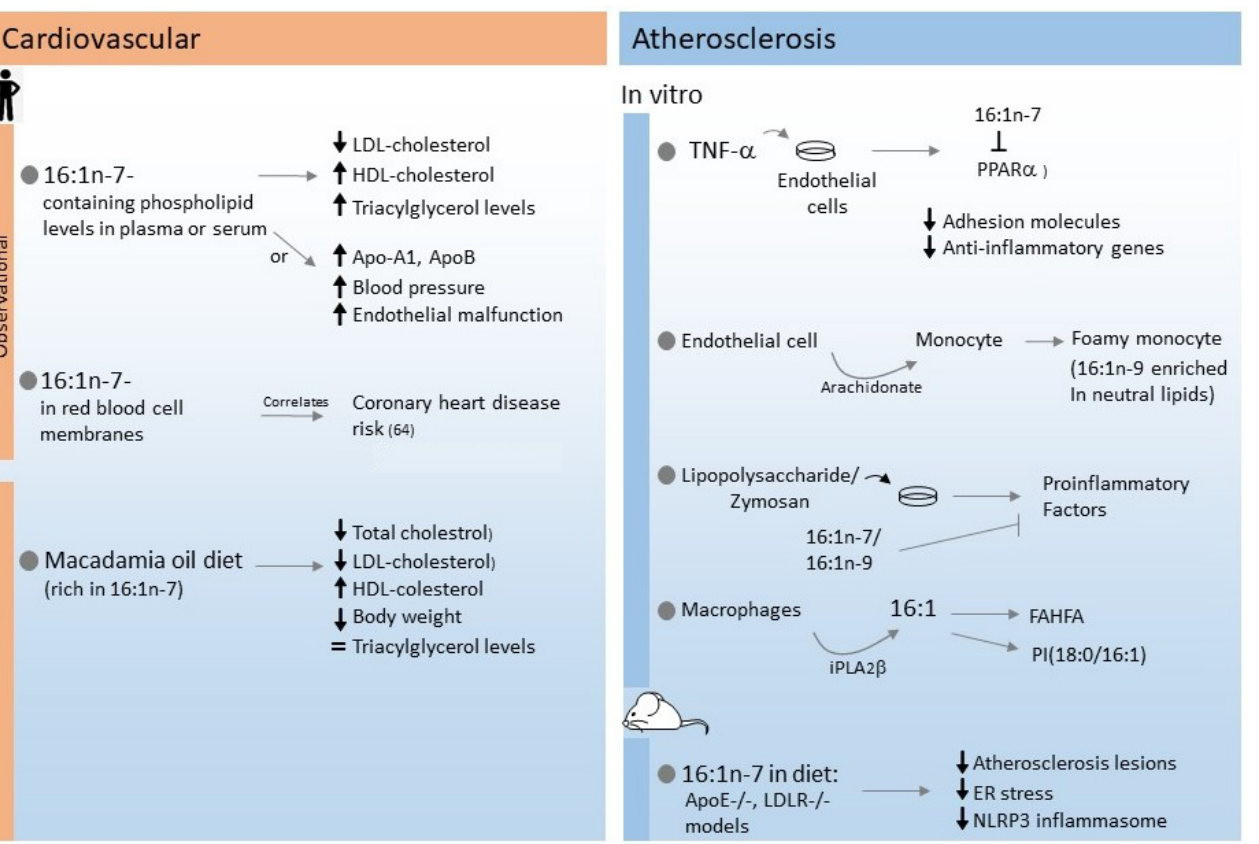
Figure 3. Summary of effects of 16:1n-7 on metabolic and inflammatory conditions in cardiovascular disease and atherosclerosis.